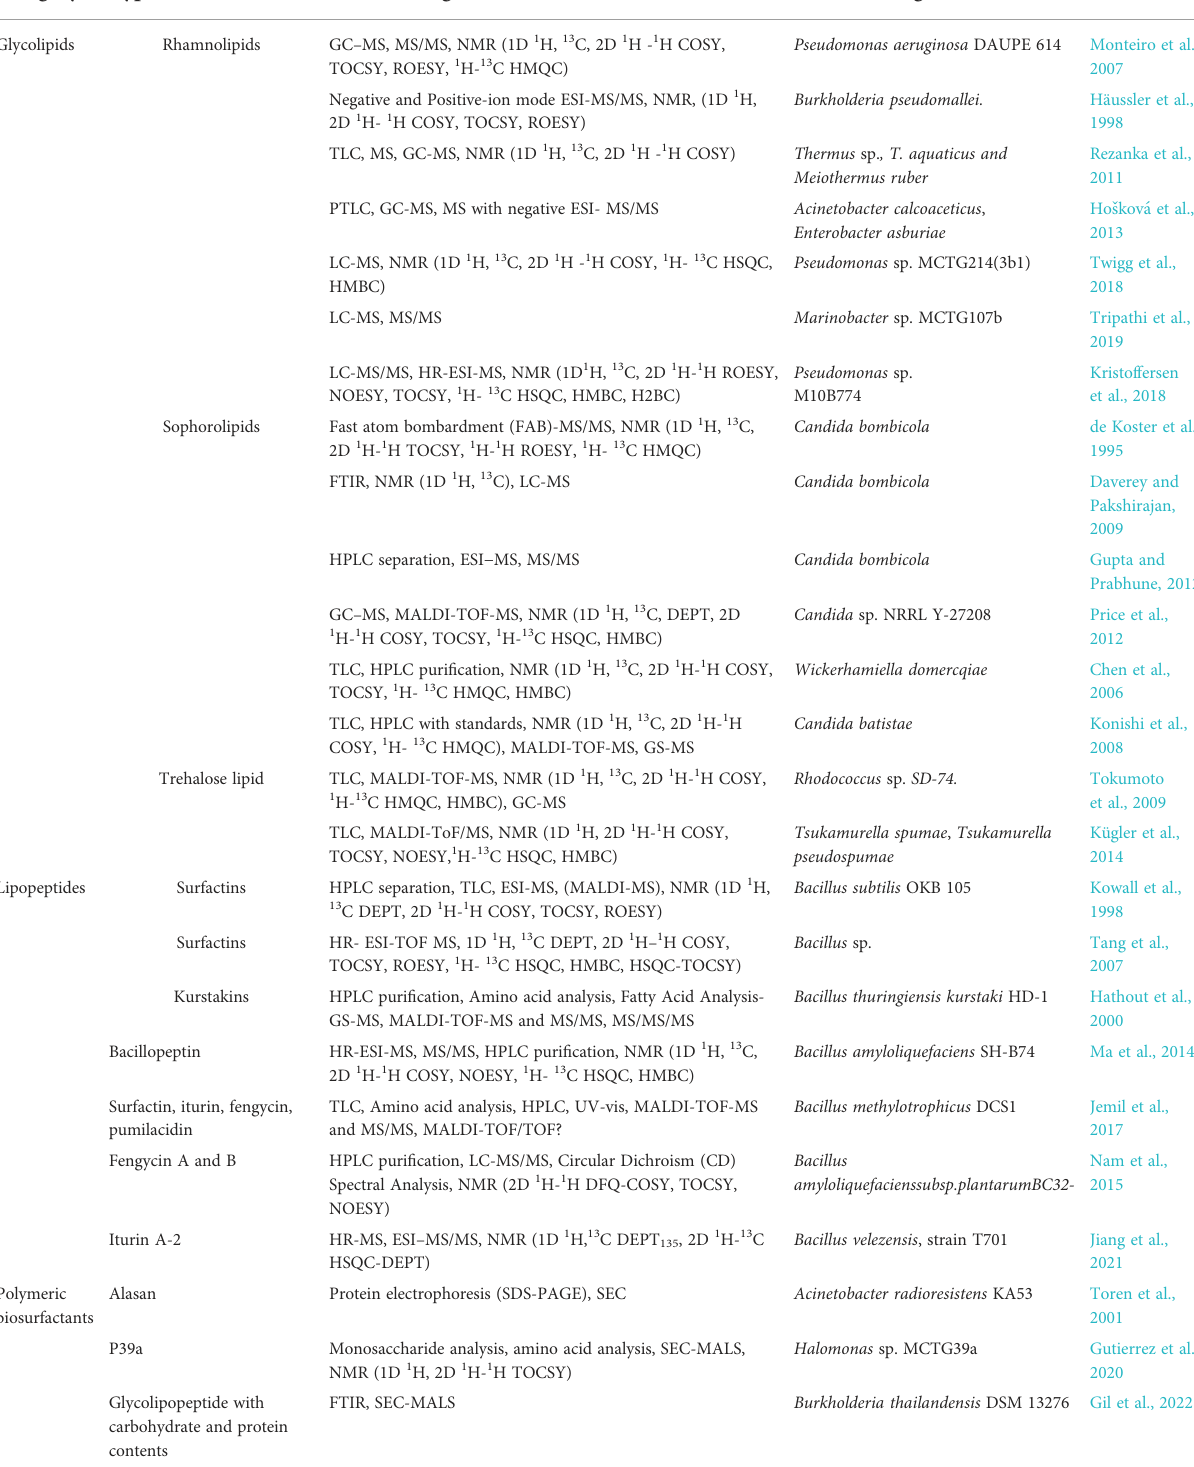
TABLE 1 Examples of applied analytical methodologies for the ef fi cient structural characterization of different biosurfactants/bioemulsi fi ers types.